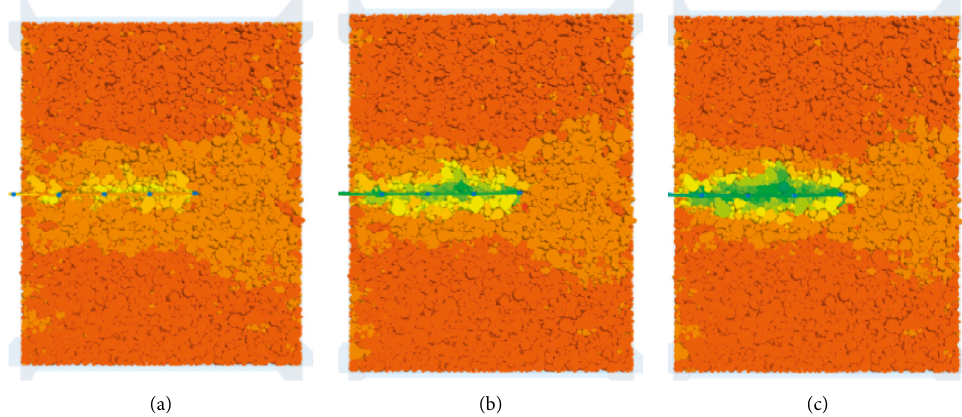
Figure 6: Evolution of the influencing zone under a vertical load of 25kPa. (a) 5mm, (b) 10mm, and (c) 15 mm.